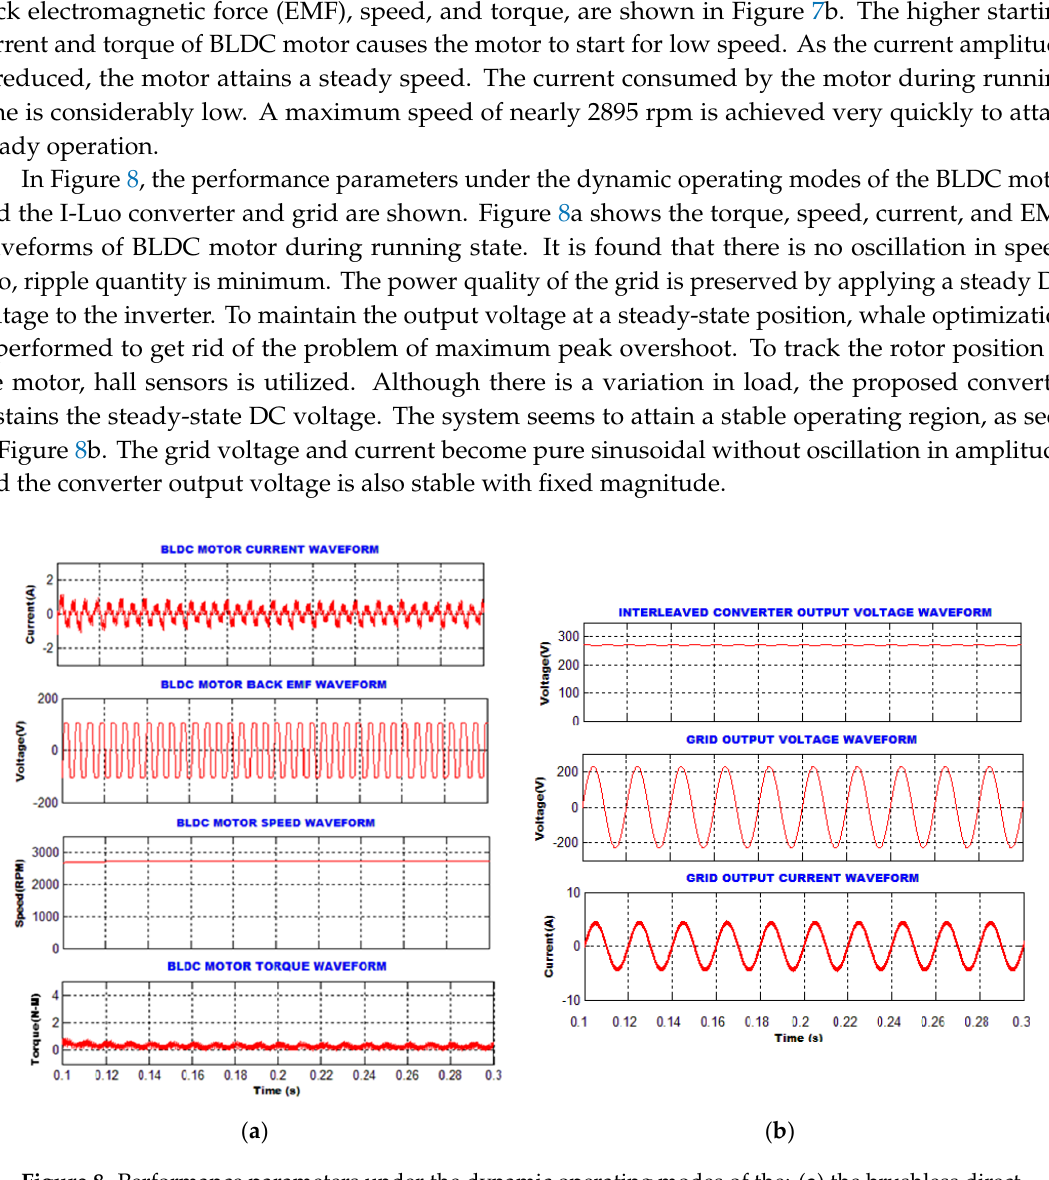
Figure 8. Performance parameters under the dynamic operating modes of the: ( a ) the brushless direct current motor; ( b ) interleaved Luo converter and grid